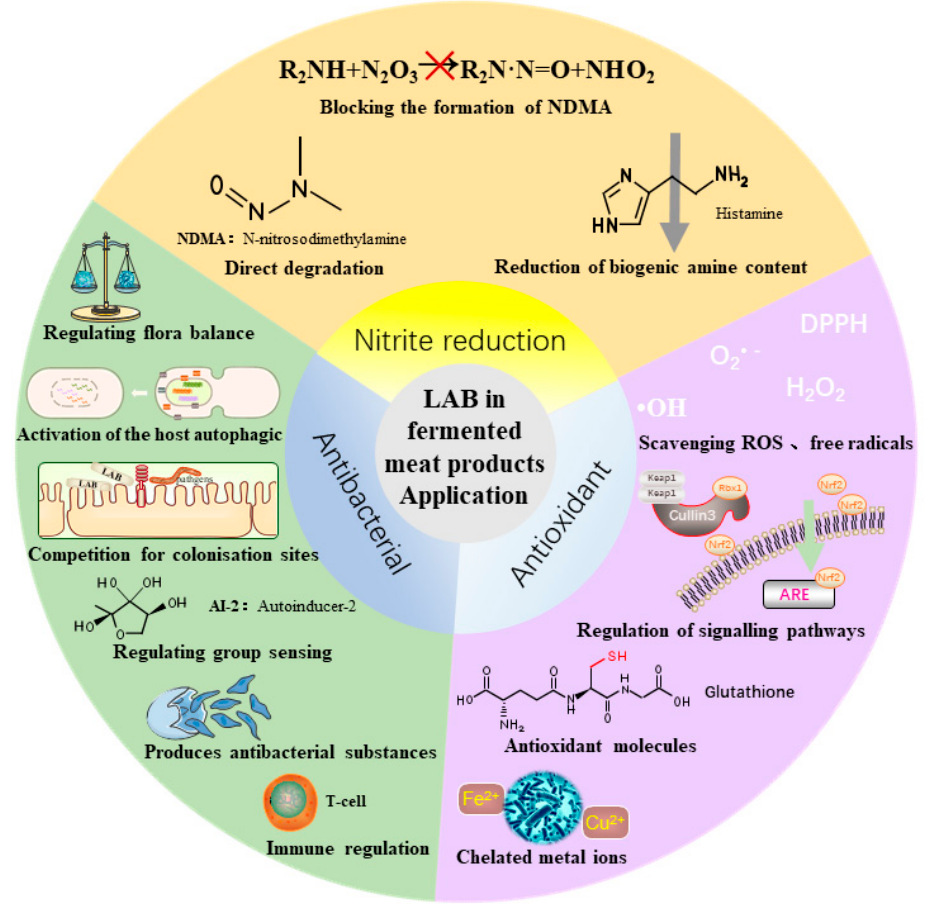
Figure 4. Functional properties of lactic acid bacteria in fermented meat products.